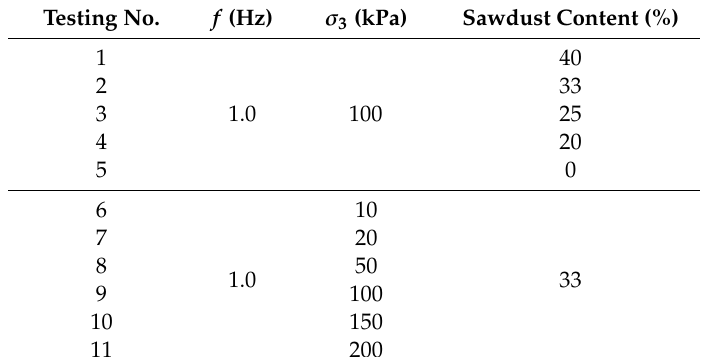
Table 3. Test program for the e ff ect of sawdust content and confining pressure. Testing No.